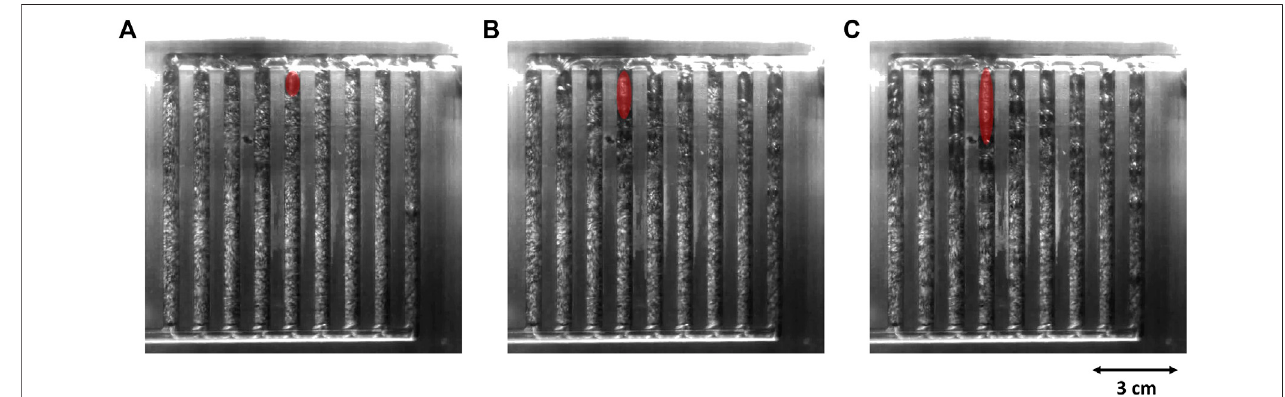
FIGURE 3 | Exemplary results from high-speed imaging of the anode fl ow fi eld of the polymer electrolyte membrane water electrolyser at (A) 0.3 A cm − 2 , (B) 0.6 A cm − 2 , and (C) 1.0 A cm − 2 at a water in fl ow rate of 10 ml min − 1 . The largest stagnant bubble at the top end of the fl ow channels is marked in red for each current density.